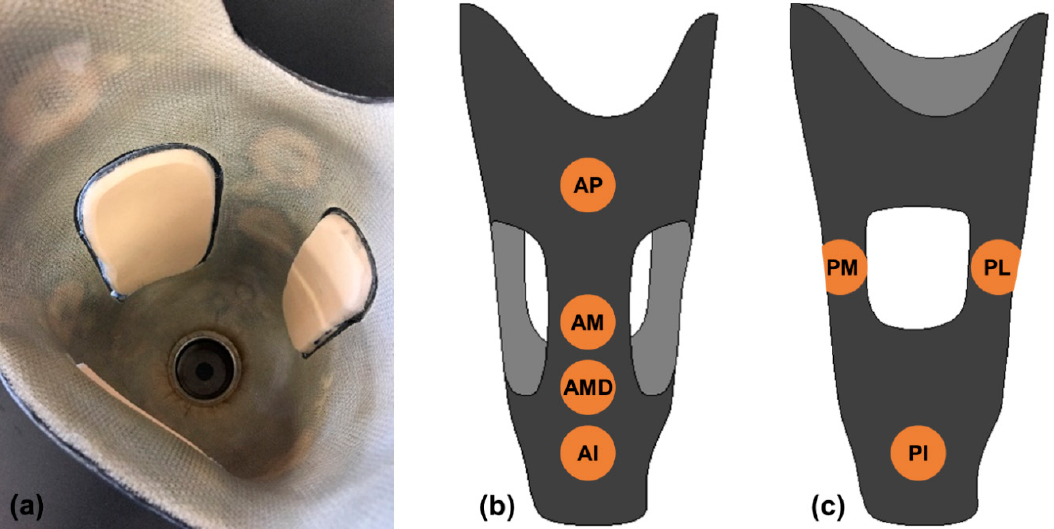
Figure 2. Sensors embedded into seven locations in the prosthetic socket: ( a ) socket with embedded sensors visible through Nyglass inner layup; ( b ) sensor locations of the anterior aspect of the socket; ( c ) sensor locations of posterior socket. Sensors anterior midlimb (AM), posterior midlimb medial (PM), and posterior midlimb lateral (PL) were fabricated on a latitudinal line at half the average height of each panel. Anterior proximal (AP); anterior midlimb distal (AMD); anterior inferior (AI); posterior inferior (PI).